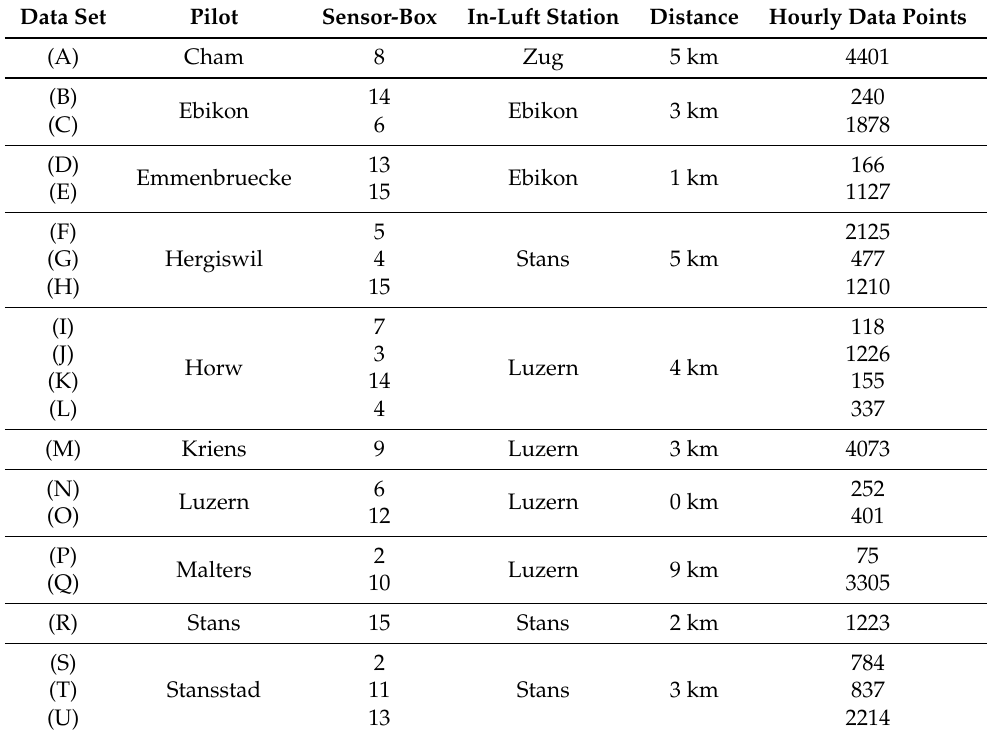
Table 7. Overview of usable data sets collected between May and December 2021 in Central Switzerland. Data Set